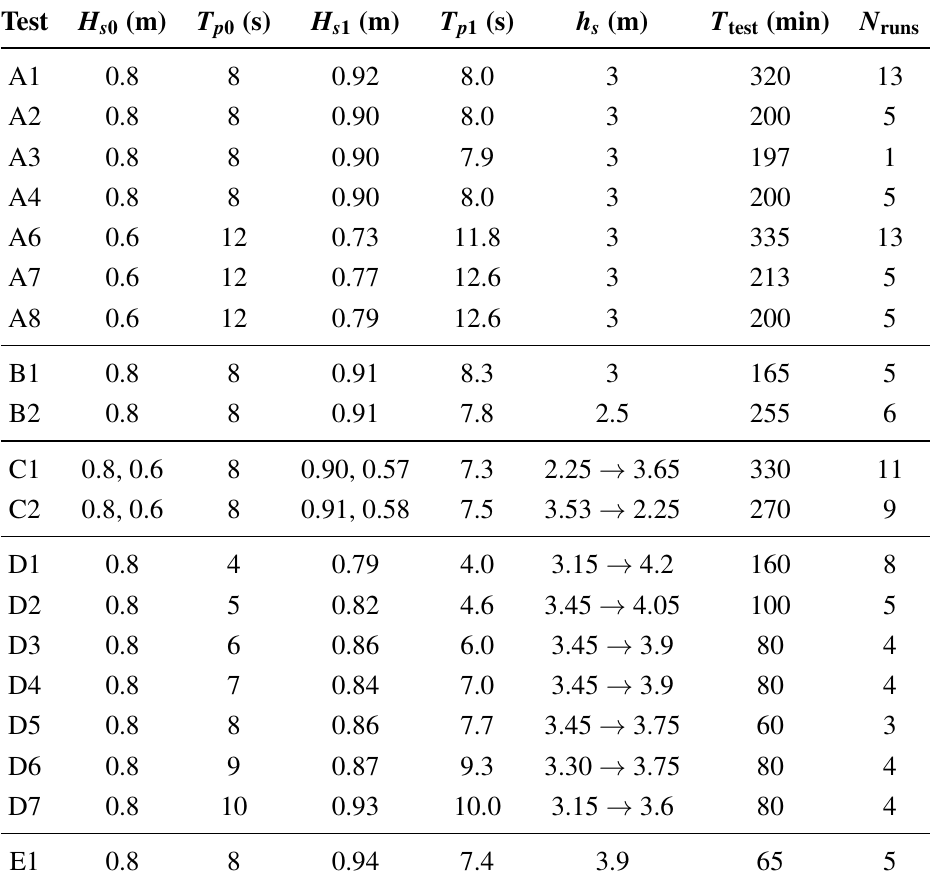
Table 1. Experimental conditions during Bardex II. H peak wave period; h = still water level with respect to the concrete flume floor; T s duration; and N is number of wave runs